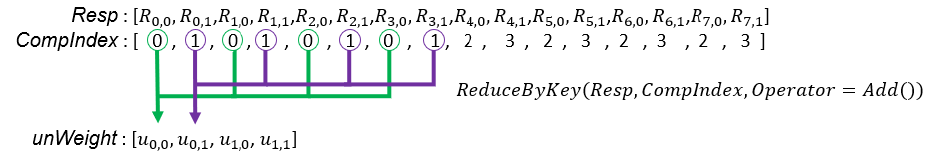
Figure 5. In this example, there are two sets of samples, and each GMM has two Gaussian components. R i , j is the probability that the Sample [ i ] is generated by the j th Gaussian component. u i , j is the non- normalized weight of the j th Gaussian component in the i th set.